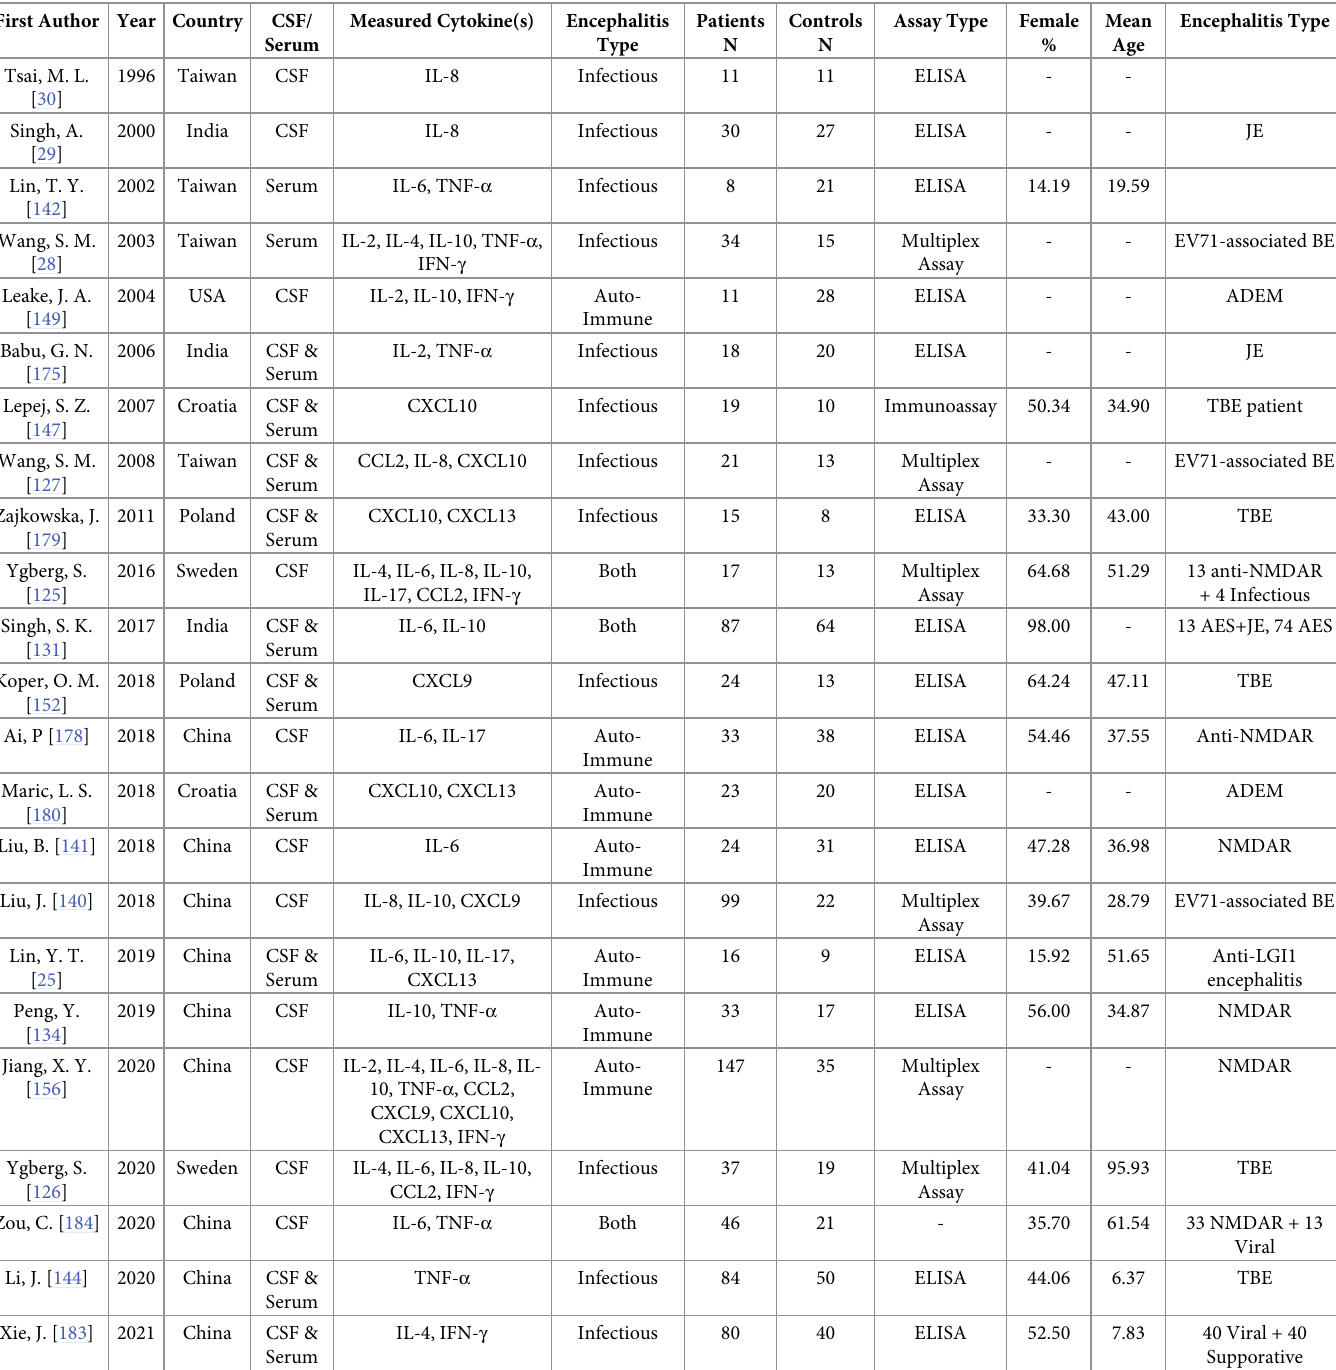
Table 1. Summary of findings from studies included in the quantitative analysis of serum/plasma or CSF levels in encephalitis disease. First Author Year